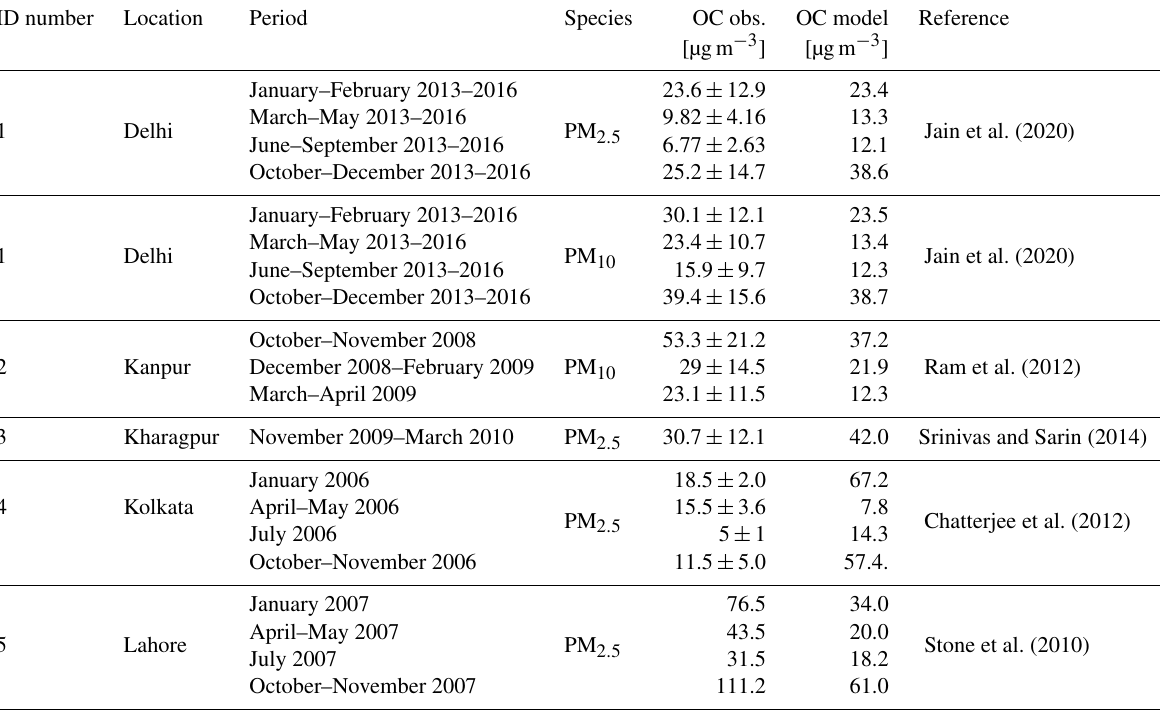
Table B4. Comparison of modelled OC with measurement studies in the literature. Model values refers to the mean over the corresponding season of observations.